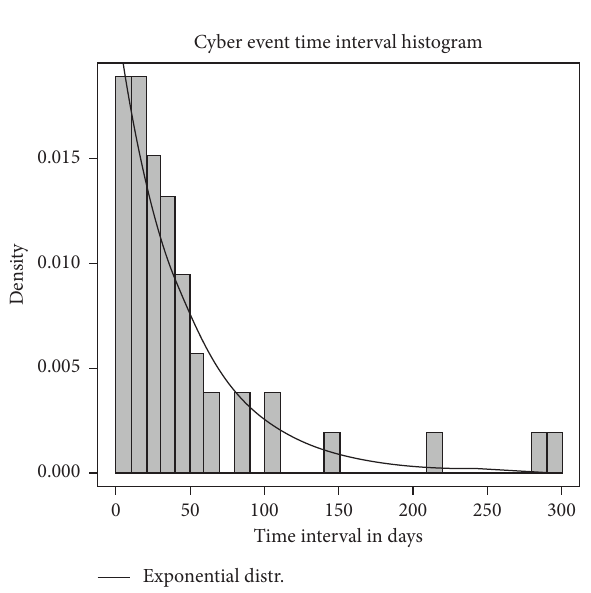
Figure 9: Histogram of time interval (in days) to the next loss and its assumed distribution.